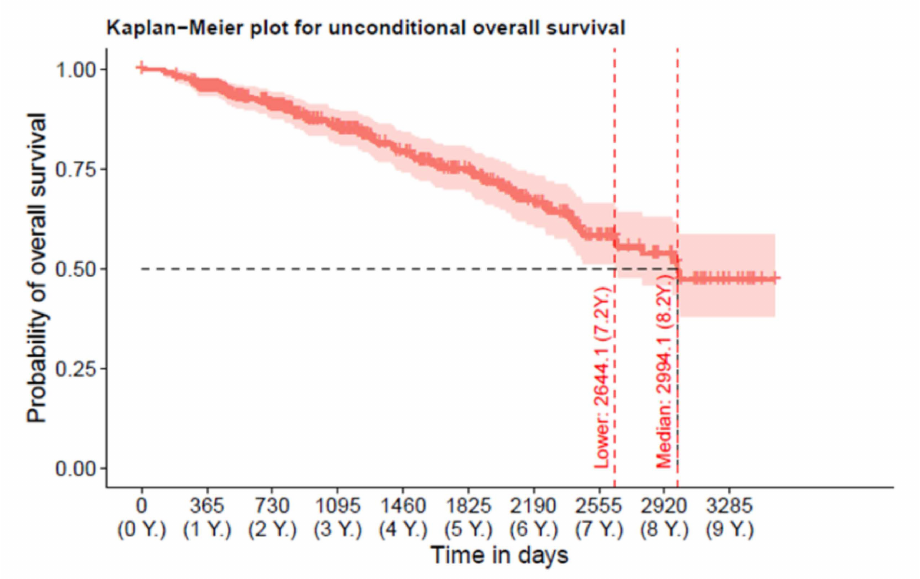
Figure 2. Kaplan–Meier plot for unconditional overall survival plus 95% confidence interval. Median (95% CI) survival time was 2994 (2644/NA) days (8.2 years). The upper bound lays outside of the observation period and is thus not